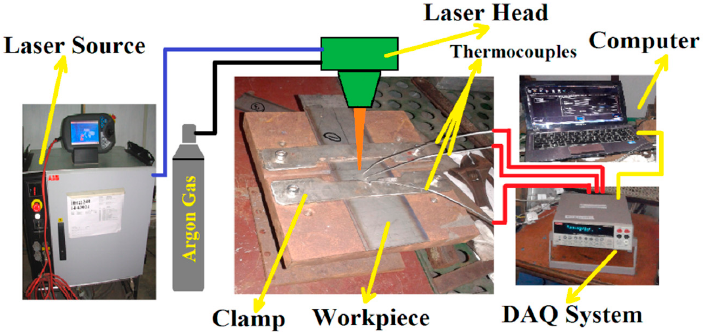
Figure 1. Schematic illustration of complete experimental setup.